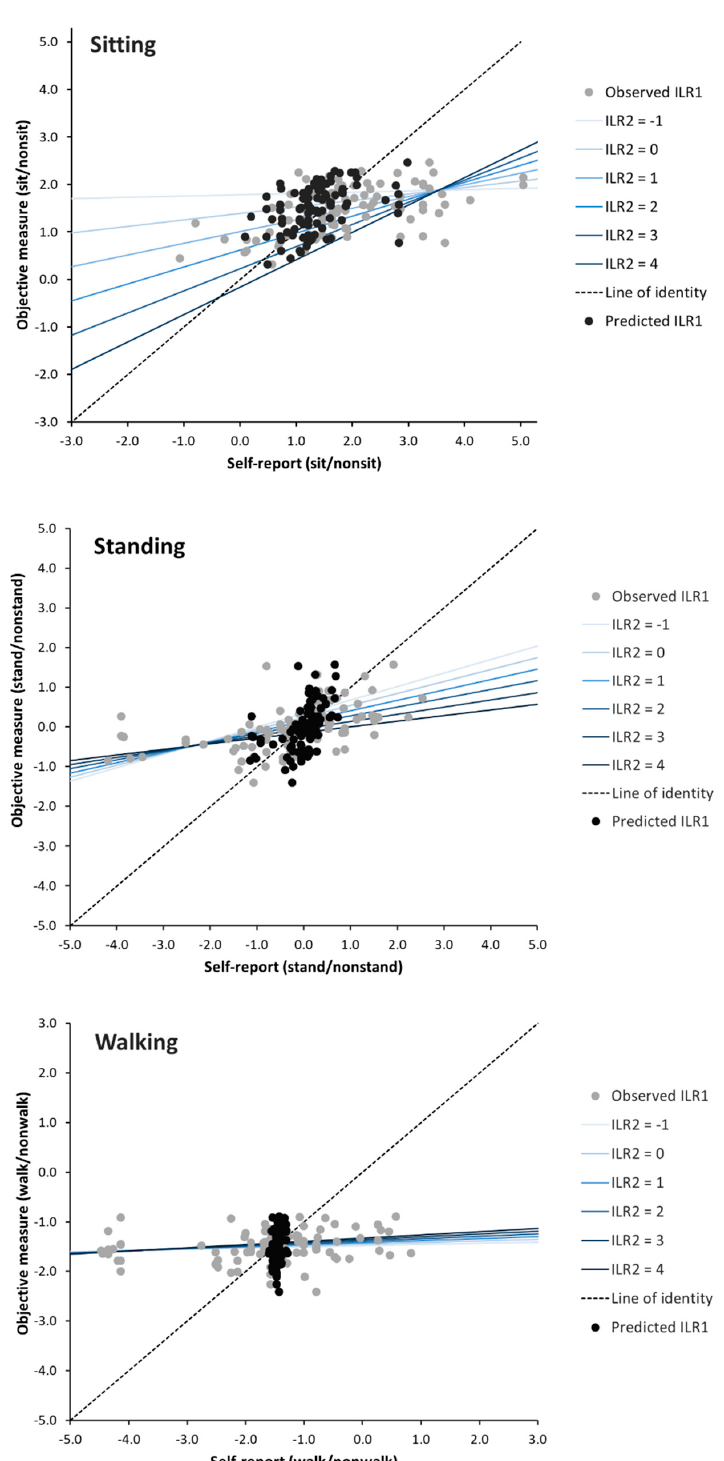
Figure 2. Self-reported and objectively measured time spent sitting, standing and walking. The x -axis represents ILR1 (e.g., sit / nonsit in the “sitting” diagram) obtained from self-reports before (grey circles) and after (black circles) calibration. The y -axis represents the same ILR calculated from objective measurements, that is, the ‘true’ ILR. As illustrated, calibration moves estimates closer to the ‘truth’, that is, closer to the line of identity. Colored lines illustrate the calibration model (see Table 3) at different values of ILR2 (e.g., stand/walk in the “sitting” diagram).